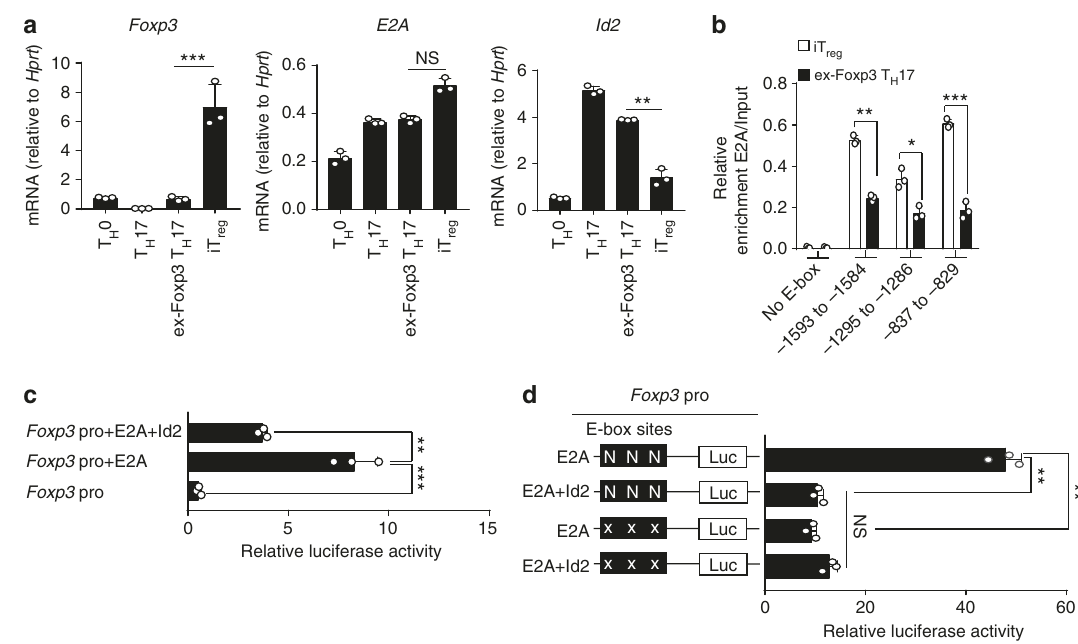
Fig. 6 Id2 expression inhibits enrichment and transcriptional activity of E2A on Foxp3 promoter. a RT - qPCR analysis of Foxp3 , E2A and Id2 mRNA in in vitro generated T H 0, T H 17, ex-Foxp3 T H 17, and iT reg cells. b ChIP-qPCR analysis for E2A occupancy at three putative E-box sites on Foxp3 promoter regions ( − 1593 to − 1584, − 1295 to − 1286, and − 837 to − 829) and negative control ( − 411 to − 244; No E-box site) in iT reg and ex-Foxp3 T H 17 cells. Enrichments are calculated relative to the input chromatin for corresponding sites. c Jurkat cells were transfected with either Foxp3 promoter reporter construct alone or along with expression plasmids encoding E2A and Id2 as indicated, followed by luciferase assay. d Effect of mutagenesis on Foxp3 promoter reporter activity. Jurkat cells were transiently co-transfected with the indicated plasmids for luciferase assay as described. N = Normal E box, X = Mutated E box. NS, not signi fi cant, *P < 0.05, **P < 0.005, ***P < 0.001 (Student ’ s t -test). All data are representative of two or three independent experiments (error bars,